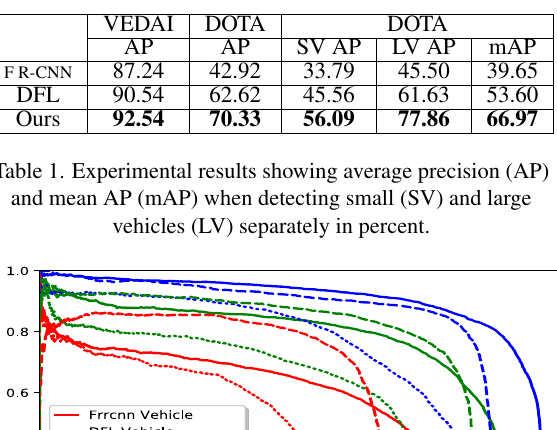
Table 3. Ablation study. STN is fed with features from different convolution blocks of the backbone network for small (SV) and large (LV)